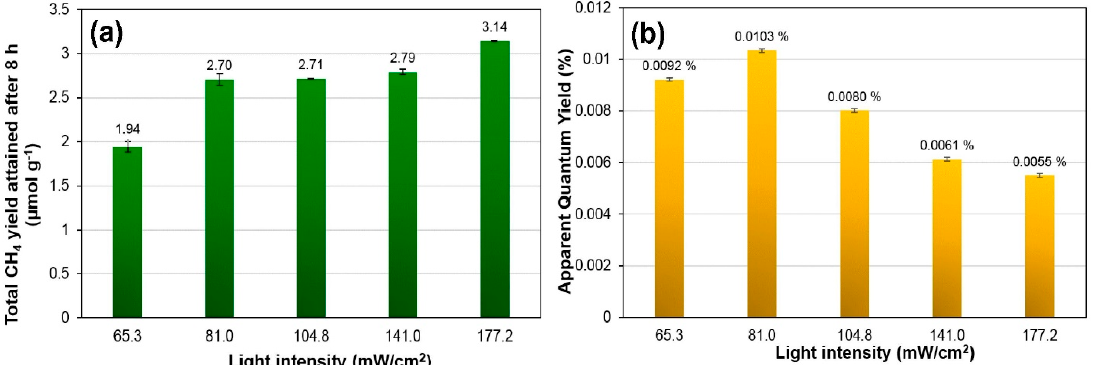
Figure 12. Effect of different light intensities at ( a ) CH 4 yield and ( b ) apparent quantum yield(AQY) at variable light intensities, reproduced with permission from reference [46]. Copyright Elsevier, 2016.